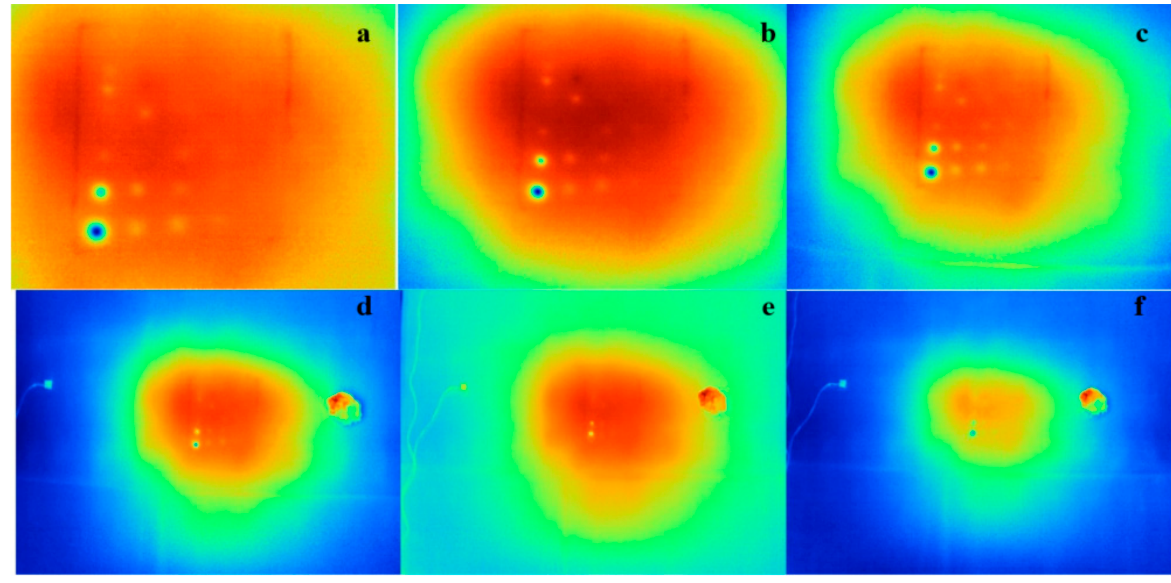
Figure 12. Thermograms captured during a single cycle with camera distances of ( a ) 0.75 m (2.5 ft),